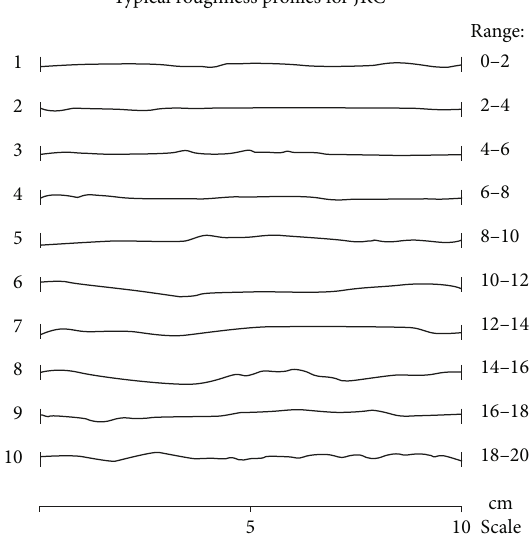
Figure 2: 10 typical roughness pro fi les showing the range of JRC values